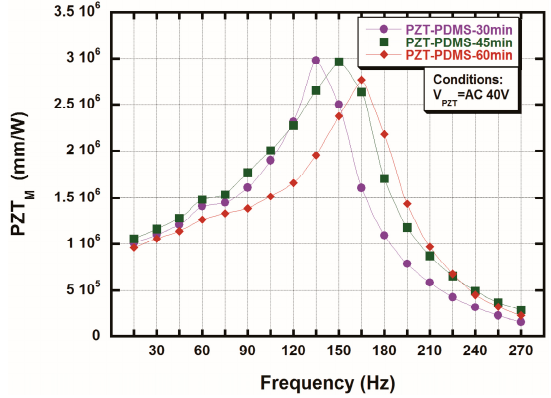
Figure 7. Vibrating amplitude per power consumption of the PZT actuators.